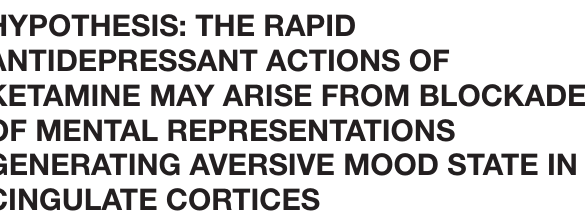
( Figure 4C ). rTMS (repetitive transcranial magnetic